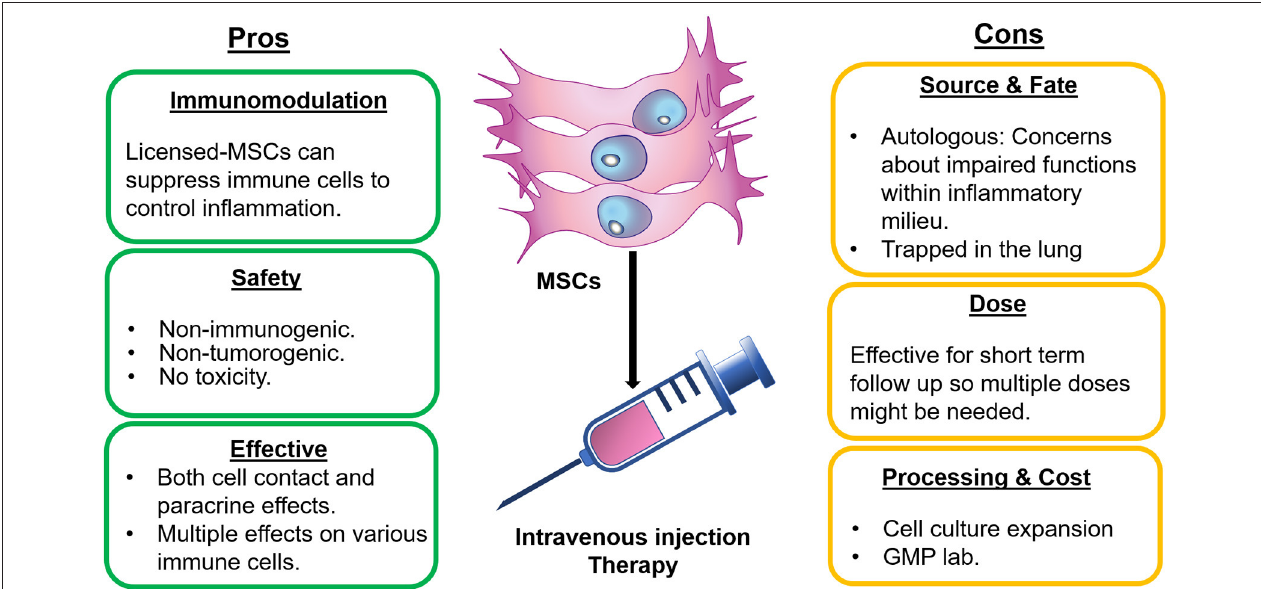
FIGURE 1 | Pros and Cons of using MSCs for RA and SLE therapies. Therapy of RA and SLE using MSCs have some advantages including the immunosuppression capacity. These cells are safe to use and having simultaneous effects on multiple immune cells and exhibition of both contact and non-contact activities. In contrast, autologous MSCs might not be effective or only effective for short term due to inflammatory milieu. Also, intravenously injected MSCs could be trapped in lungs. Additionally, this therapy usually necessitates GMP lab for expansion of MSCs in culture.